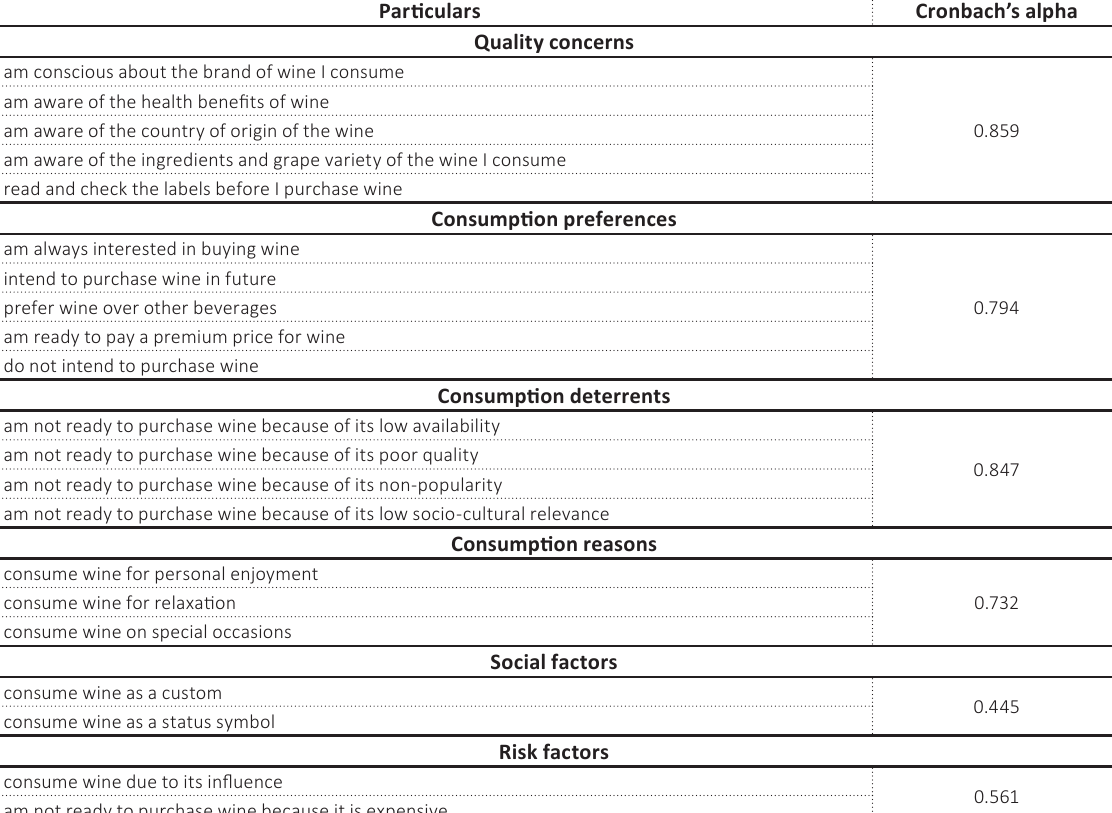
Table 2. Variables, factors, and